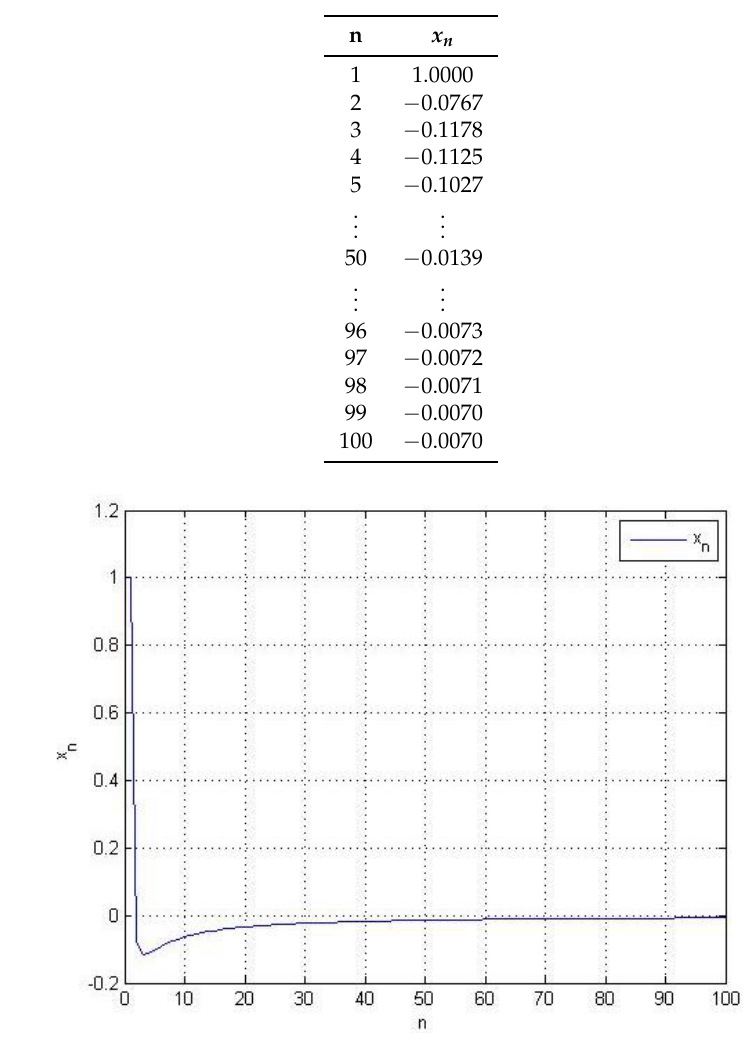
Table 1. The values of { x n } with N = 100, n = 100.